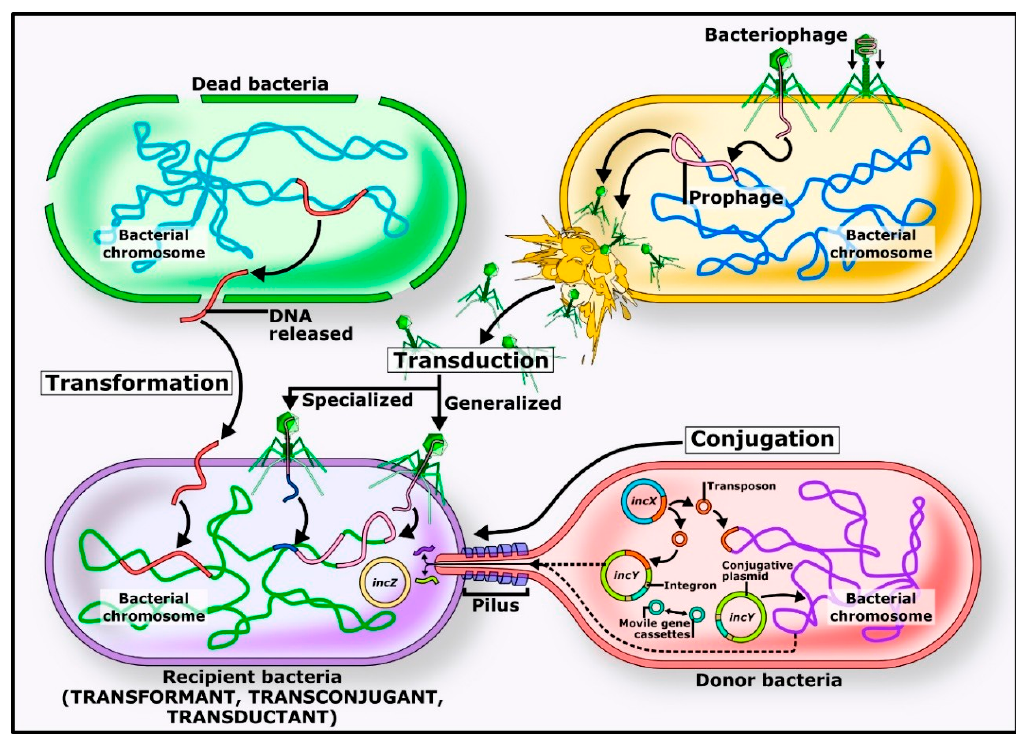
Figure 1. Mechanisms of horizontal gene transfer in bacteria [10]. Note: the main routes of transmission of genetic material between bacteria are transformation, transduction and conjugation. Genes can pass between related and non-related species by these routes. These mechanisms of transmission allow bacteria to evolve to survive.